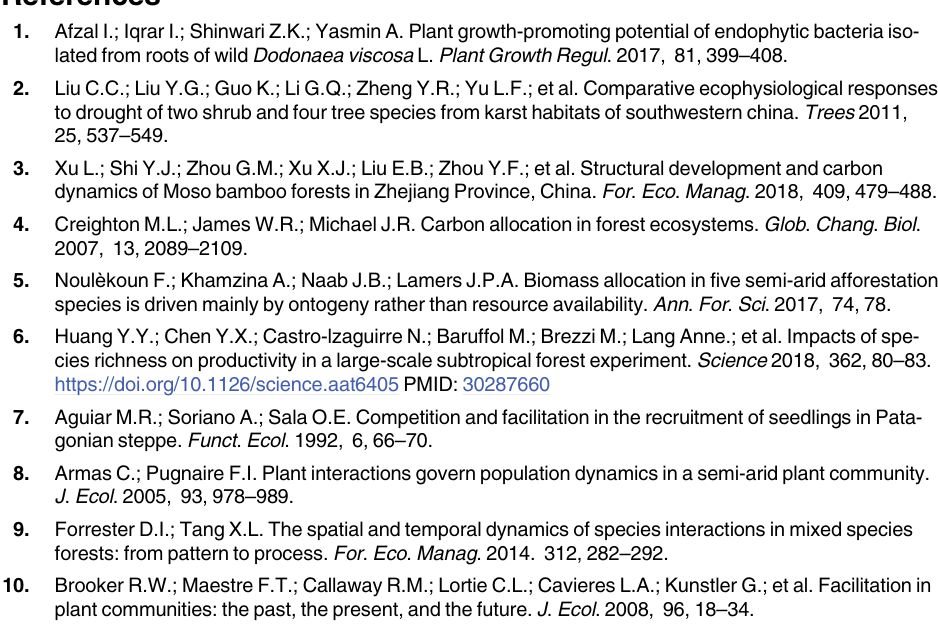
S1 Table. Vegetation biomass (t/hm2) in the different vegetation restoration types. S2 Table. Individual contribution of primary parameters to the proportion (%) of varia- tion explained in biomass and carbon concentration of different